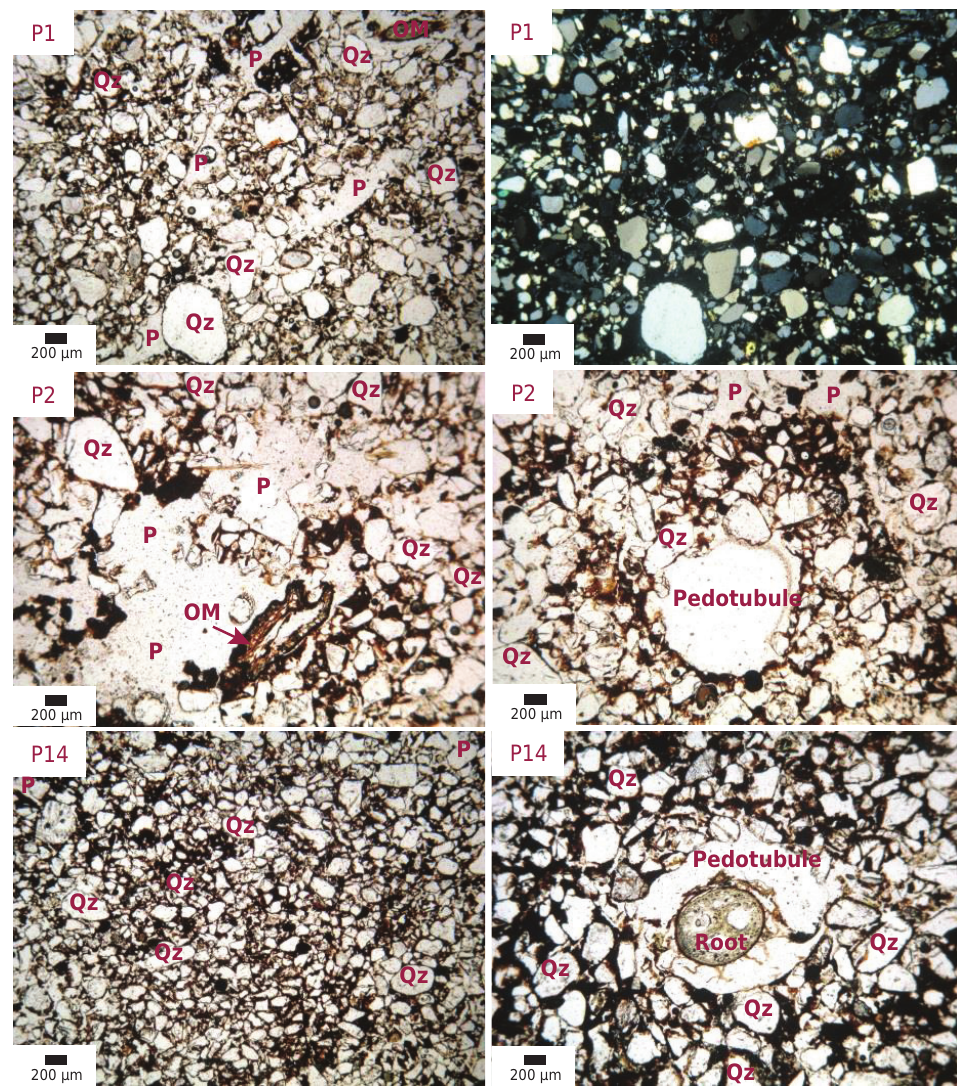
Figure 2. Photomicrographs of some selected soil layers under an optical microscope, in flat light, highlighting different sections with solid microstructure, showing higher porosity (P) in P1 and P2 (planar pores), and lower porosity in P14. The groundmass consists of fine quartz grains (Qz = coarse material) and reddish clay (micromass). Pedofeatures such as organic matter fragments (OM) and coating were observed. Relative distribution showed a gefuric pattern in P1 and P2, and a chitonic/porfiric pattern in P14, due to intensive agricultural use and soil